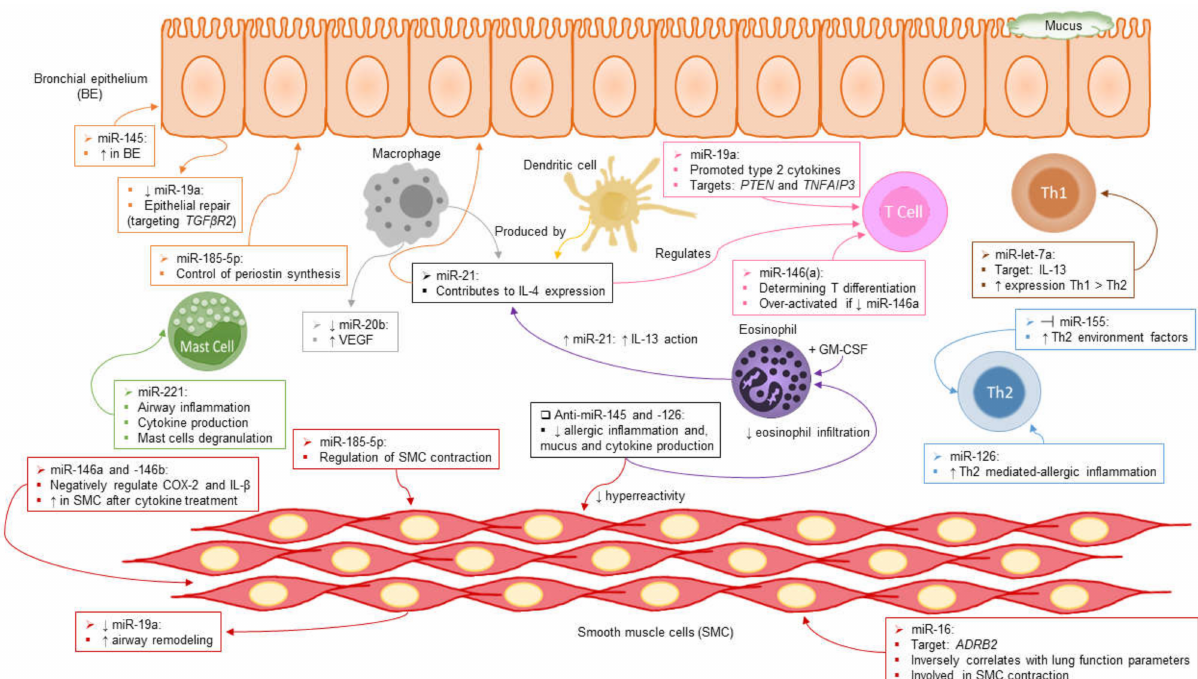
Figure 1. Role of miRNAs through the diverse pathophysiological mechanisms of asthma disease. miRNAs are able to regulate the functions of the airway structural cells, starting with bronchial epithelial cells, where miRNAs control remodeling, repair, and cytokine synthesis, and continuing with the smooth muscle compartment, as there are reports of miRNAs regulating contraction, hy- peractivity, remodeling, and cytokine production. T cells (both Th1 and Th2) are also targets for miRNA-modulation in asthma, especially regarding polarization of immune responses toward the T2 axis. The behavior of eosinophils, the main effectors of severe asthma, is also regulated by miRNAs, altering their tissue infiltration capacity; meanwhile, other miRNAs control basophil degranulation and cytokine release. Finally, miRNAs are capable of tuning the actions of macrophages and dendritic cells, modulating their cytokine production above